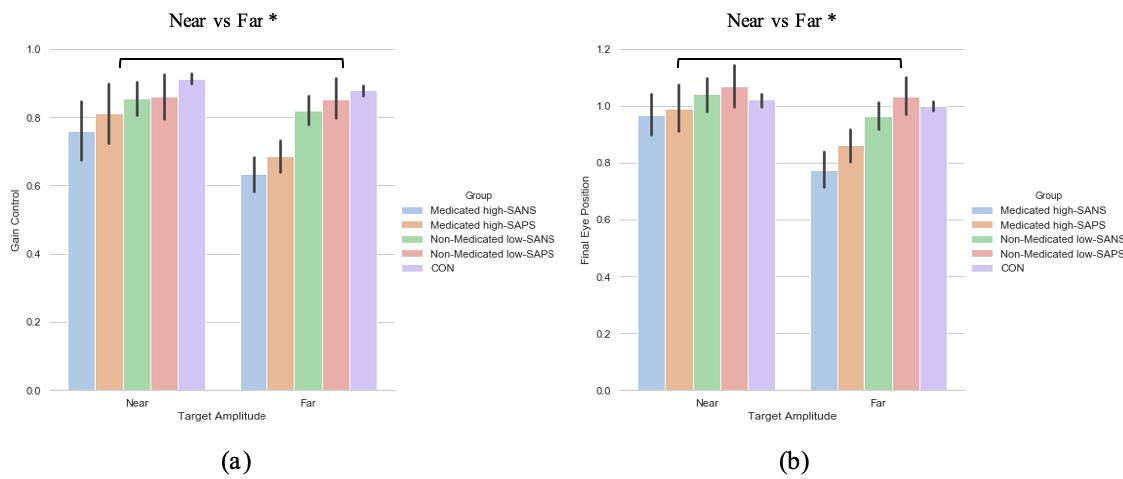
Figure 5. A comparison of performance in the ( a ) gain and ( b ) final eye position measures between the two target eccentricities and the high-/low- SANS/SAPS groups (regardless of diagnostic category). For reference, the control cohort are included here but were not included in the reported analysis. * refers to significance at the p < 0.05 level. Error bars refer to the standard error.